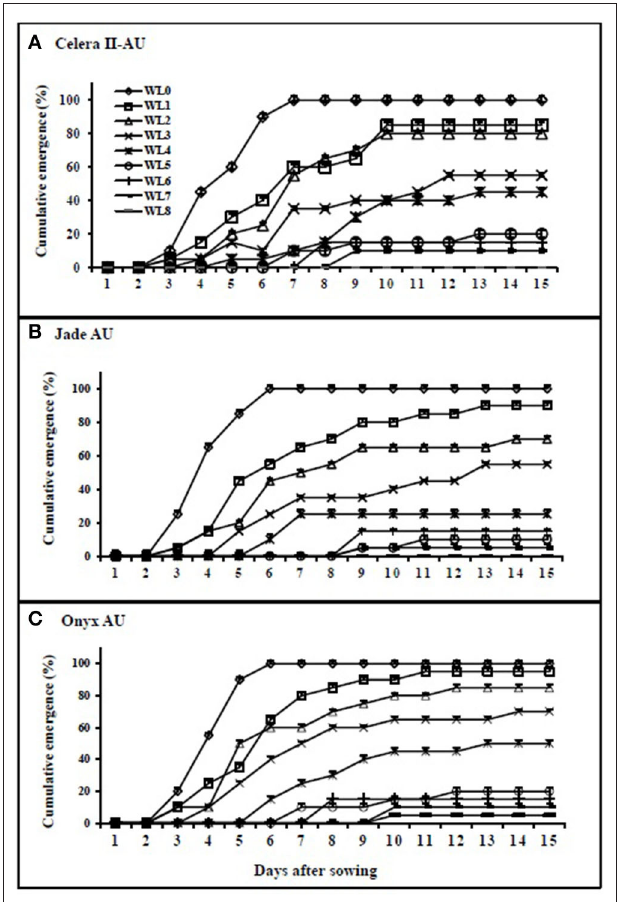
FIGURE 1 | Percentage of cumulative emergence in mungbean (A) Celera II-AU and (B) Jade-AU and blackgram (C) Onyx-AU under different durations of waterlogging and subsequent recovery. WL0, drained control; WL1, waterlogging for 1 day and recovery for 14 days; WL2, waterlogging for 2 days and recovery for 13 days; WL3, waterlogging for 3 days and recovery for 12 days; WL4, waterlogging for 4 days and recovery for 11 days; WL5, waterlogging for 5 days and recovery for 10 days; WL6, waterlogging for 6 days and recovery for 9 days; WL7, waterlogging for 7 days and recovery for 8 days; WL8, waterlogged (WL) 8 days and recovery for 7 days. Symbols are means ± SE of three replicates.